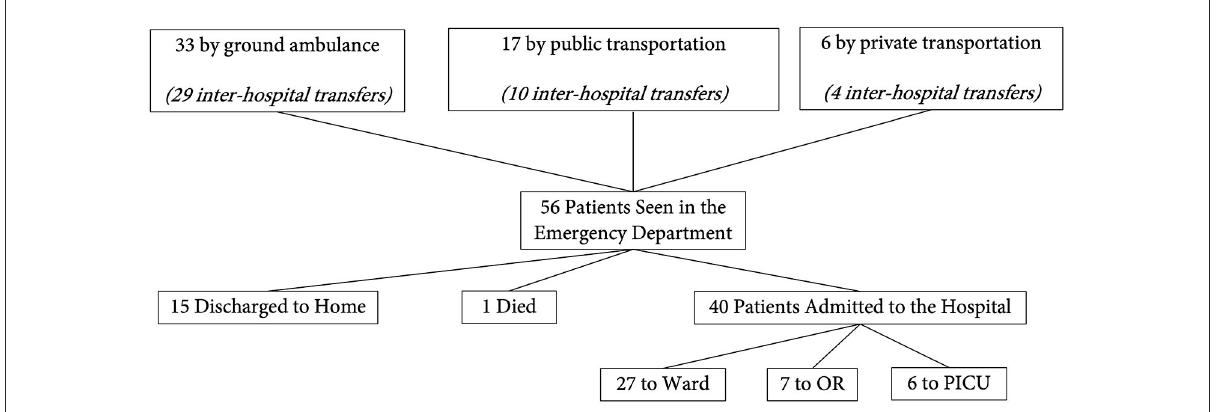
FIGURE1 Patient flow diagram. This figure demonstrates the flow of our patients from the pre-hospital, emergency department, and in-hospital settings. OR, operating room; PICU, pediatric intensive care